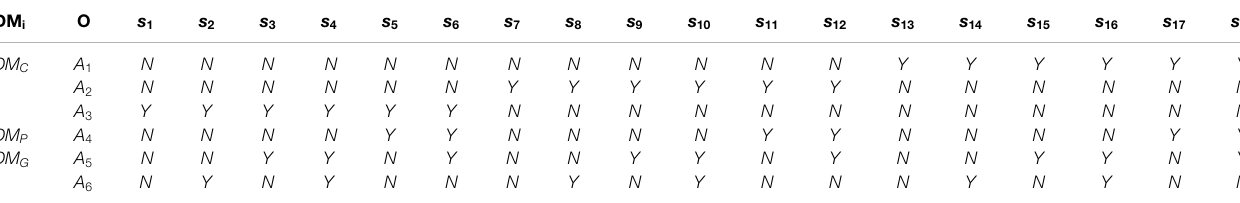
TABLE 3 | Feasible states of ternary con fl ict in coal- fi red power industry